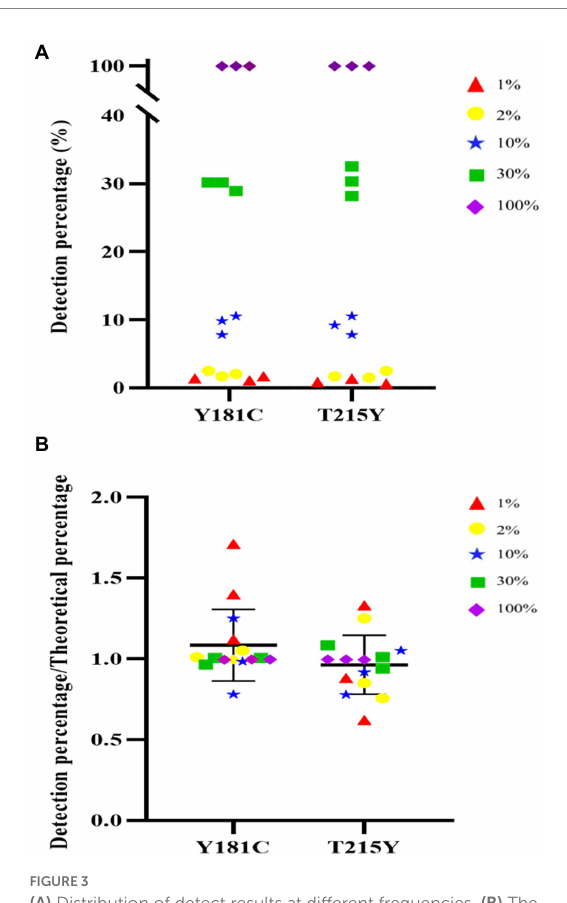
FIGURE 3 (A) Distribution of detect results at different frequencies. (B) The distribution of the ratio of the detection frequency to the theoretical frequency.